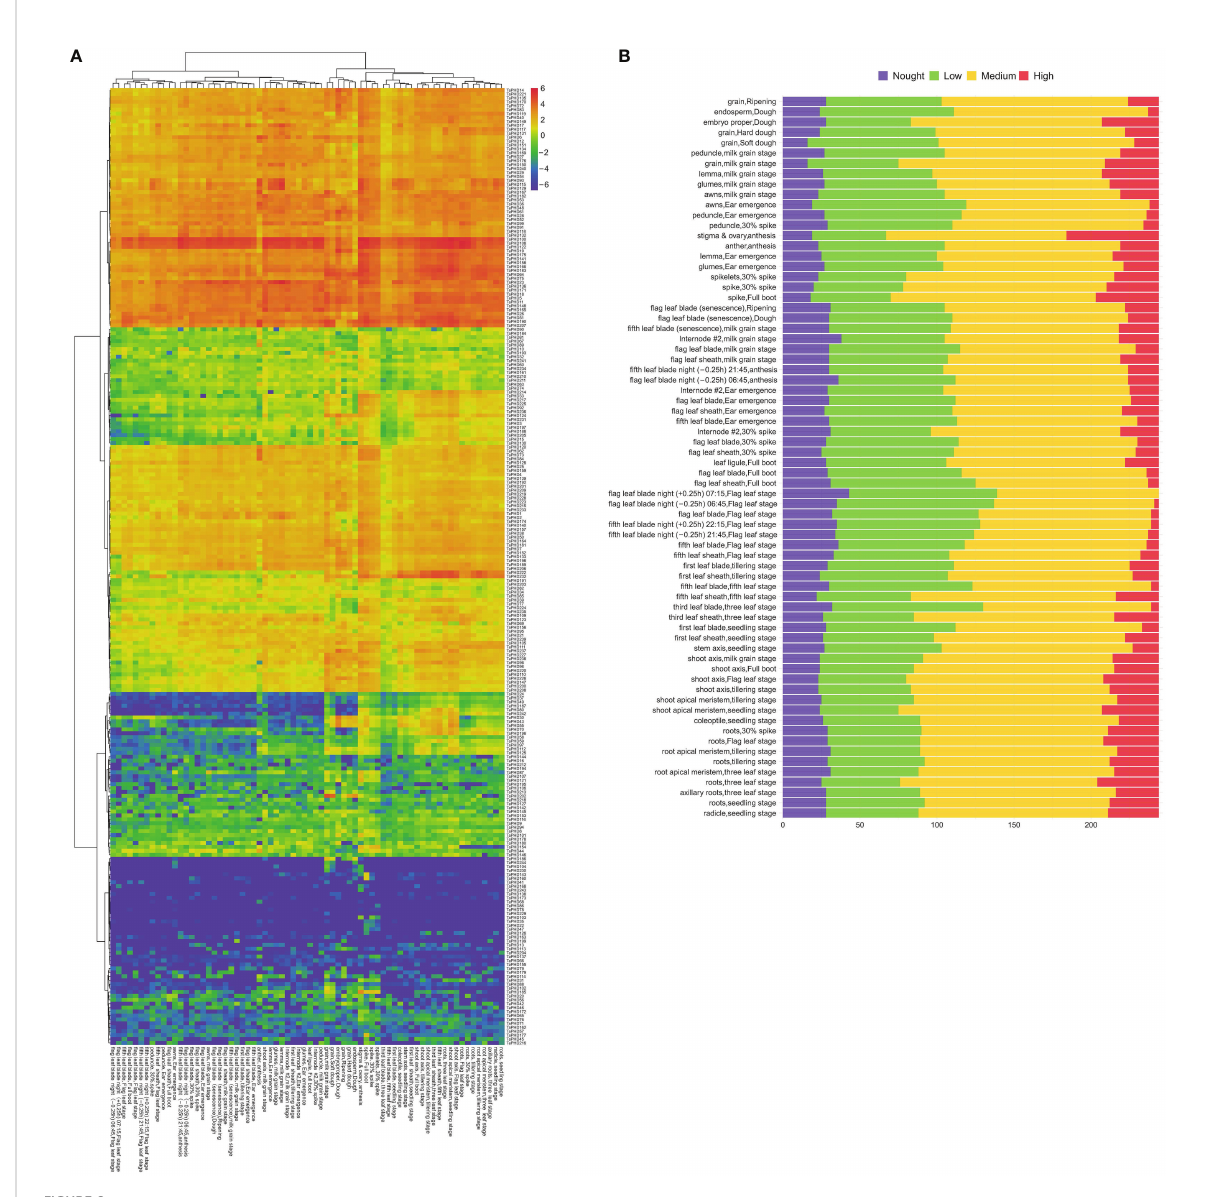
FIGURE 8 Transcriptome analyses of TaPHDs in different tissues. (A) Heat map of expression pro fi les for 244 TaPHD genes in different tissues. Red color indicates high expression levels; blue color indicates low expression levels. The gradual change of the color indicates different levels of gene log2-transformed expression. (B) Numbers of expressed genes in different tissues. High: TPM values >10, medium: 10 ≥ TPM values > 1, low: 1 ≥ TPM values > 0, none: TPM values =